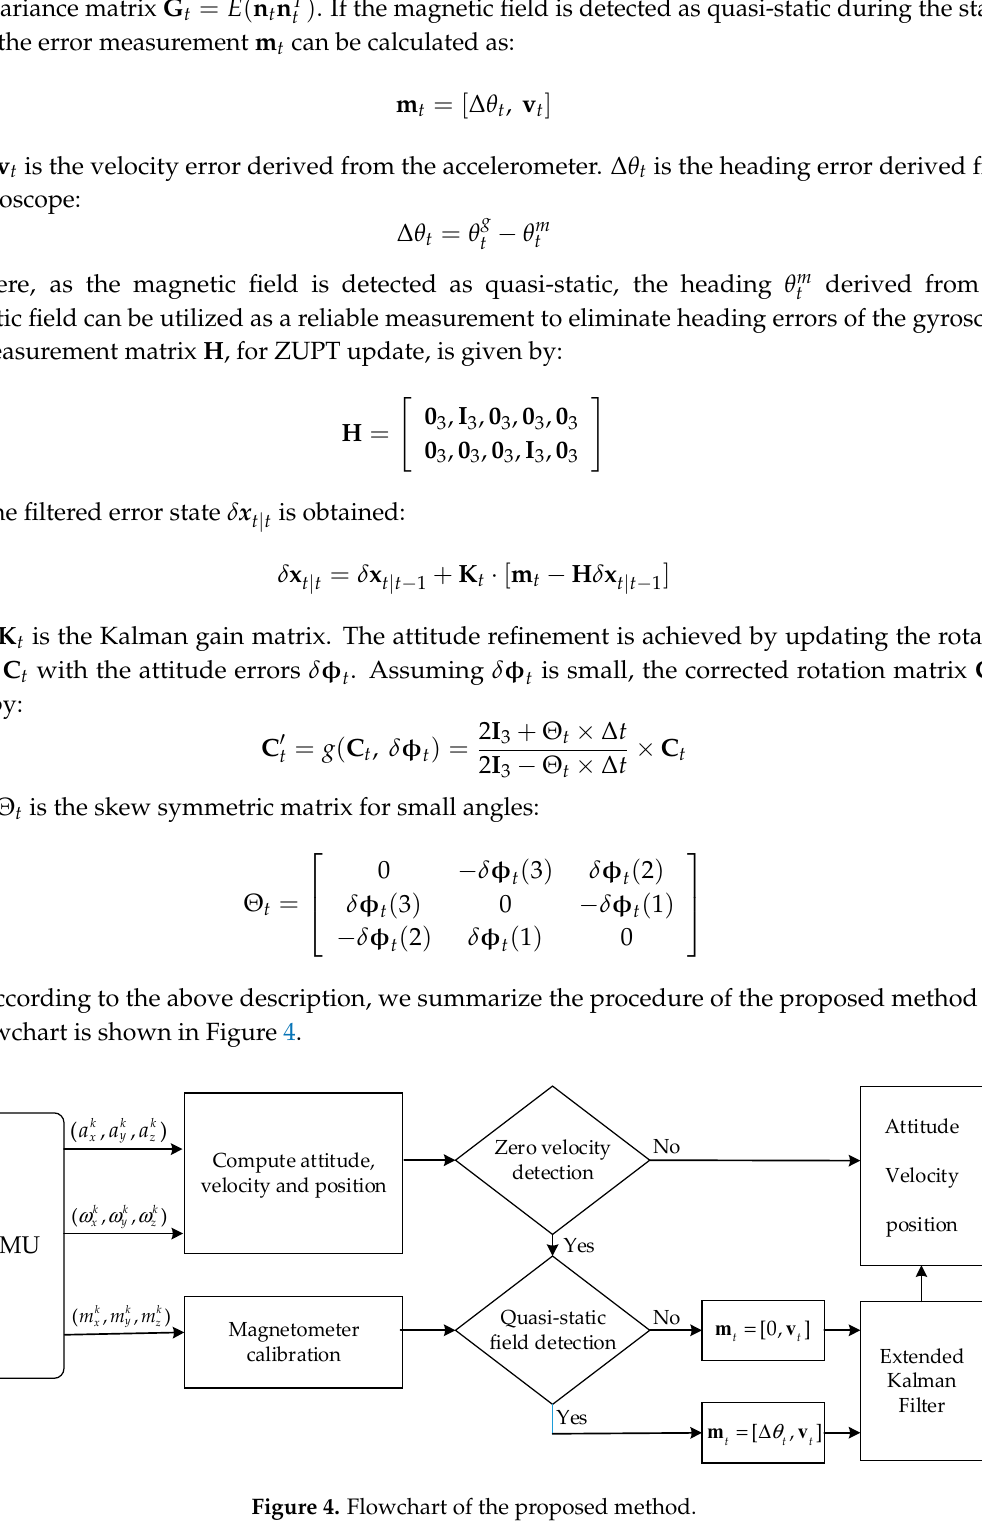
Figure 4. Flowchart of the proposed method.